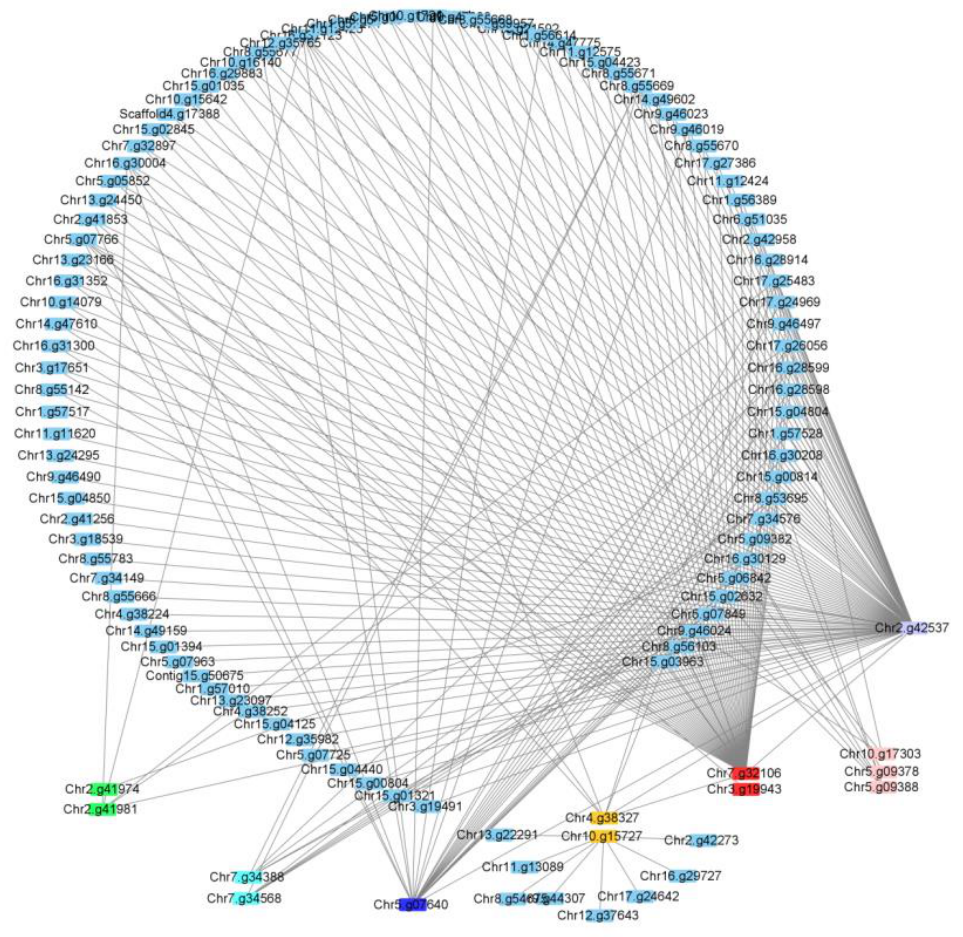
Figure 7. Co-expression network of NLR genes. All NLR genes were annotated and network relationships were constructed (Cut-off weight >